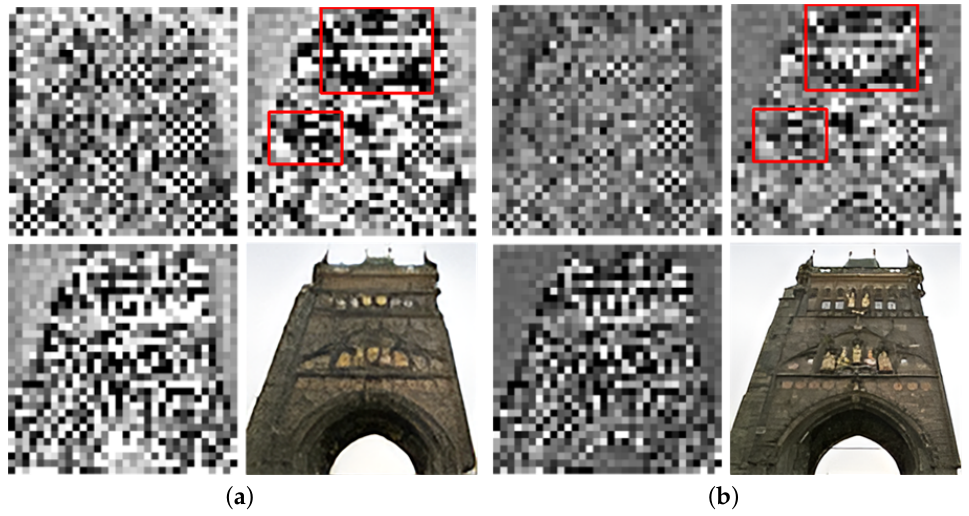
Figure 8. Further results of LSUN using L 1 regular term. ( a ) LSUN without L 1 regular term; ( b ) LSUN with L 1 regular term.